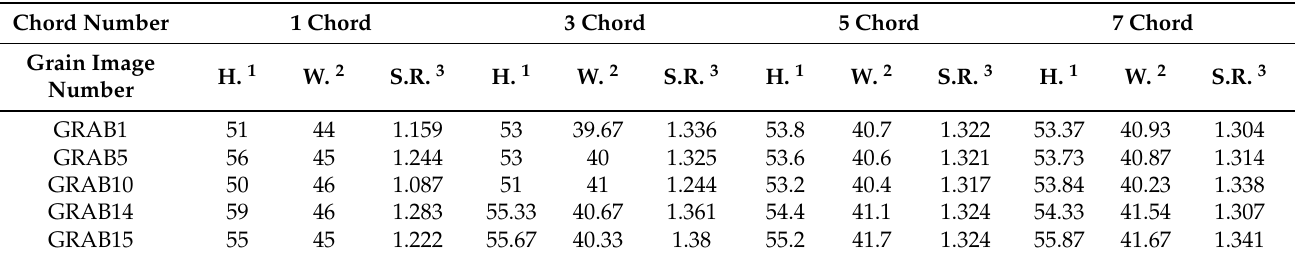
Table 2. The multi-chord grain fitting data and shape parameters (grain